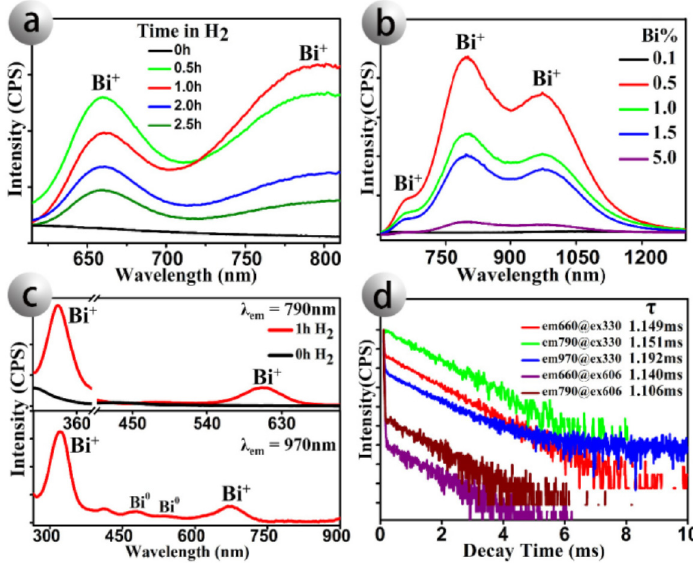
Figure 21. ( a ) Emission spectra ( λ ex = 330 nm) of Ba 1.99 B 5 O 9 Cl: 1%Bi treated in N 2 /H 2 for different time; ( b ) emission spectra ( λ ex = 330 nm) of Ba 2(1-x%) B 5 O 9 Cl: 2x%Bi (x = 0.1, 0.5, 1.0, 1.5, 5.0) treated in N 2 /H 2 for 1h detected by visible and NIR photomultipliers; the spectra were rescaled and combined; ( c ) excitation spectra ( λ em = 790 nm, λ em = 970 nm) of Ba 1.99 B 5 O 9 Cl:1% Bi treated in N 2 /H 2 for 1h and 0h; ( d ) decay curves of Ba 1.99 B 5 O 9 Cl:1% Bi treated in H 2 /N 2 for 1h. Reprinted from [227] with permission.